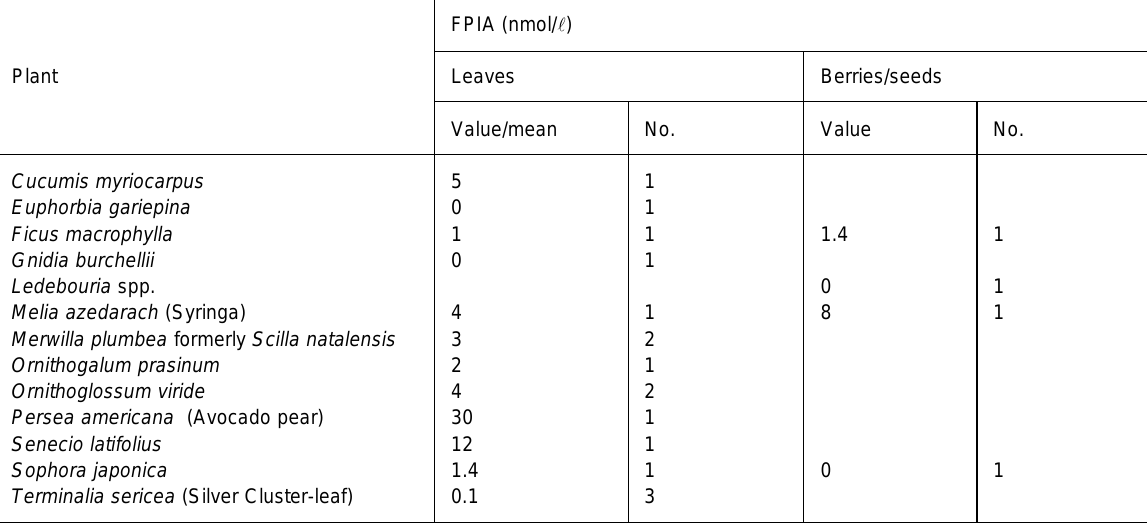
TABLE 3 FPIA values in plants not known to contain cardiac glycosides Plant Leaves